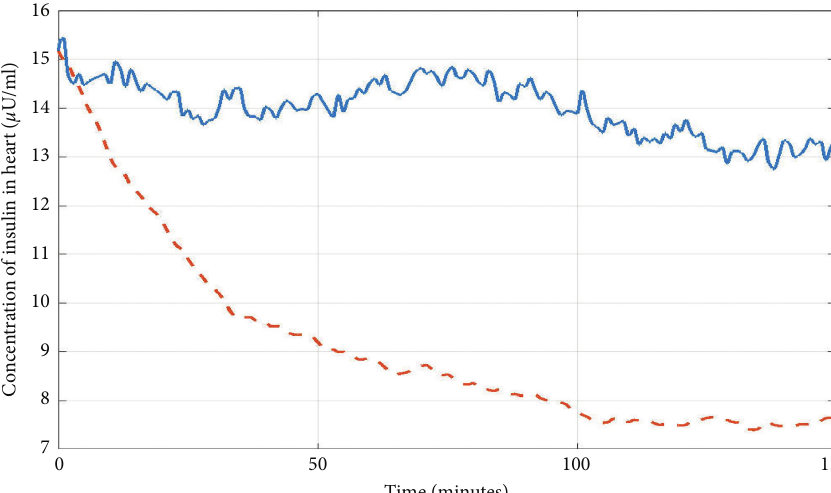
Figure 7: Profile of insulin in heart during euglycemic hyperinsulinemic clamp test. The dashed line shows the type 2 diabetic patients hyperglycemic clamp test, while the solid line shows the same for healthy